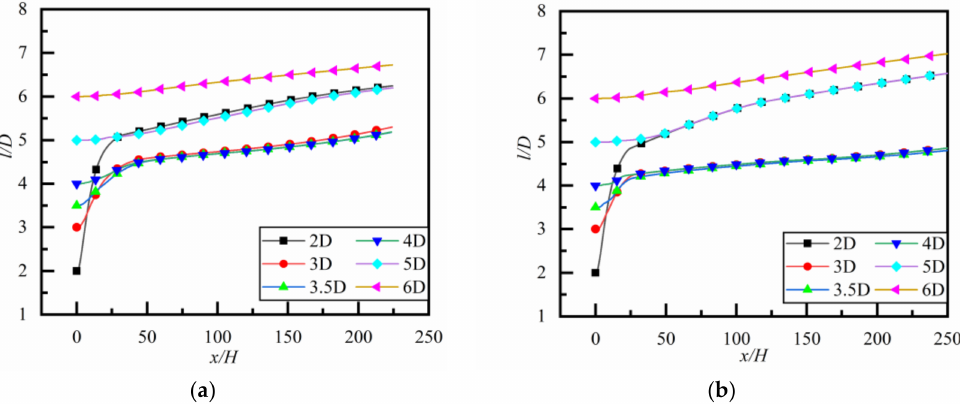
Figure 5. Inter-particle spacing at the initial stage for a single-scale particle pair ( k = 0.4, Re = 20); ( a ) flow domain 2000 × 150 ∆ x (D = 60 ∆ x ); ( b ) flow domain 2000 × 80 ∆ x (D = 32 ∆ x